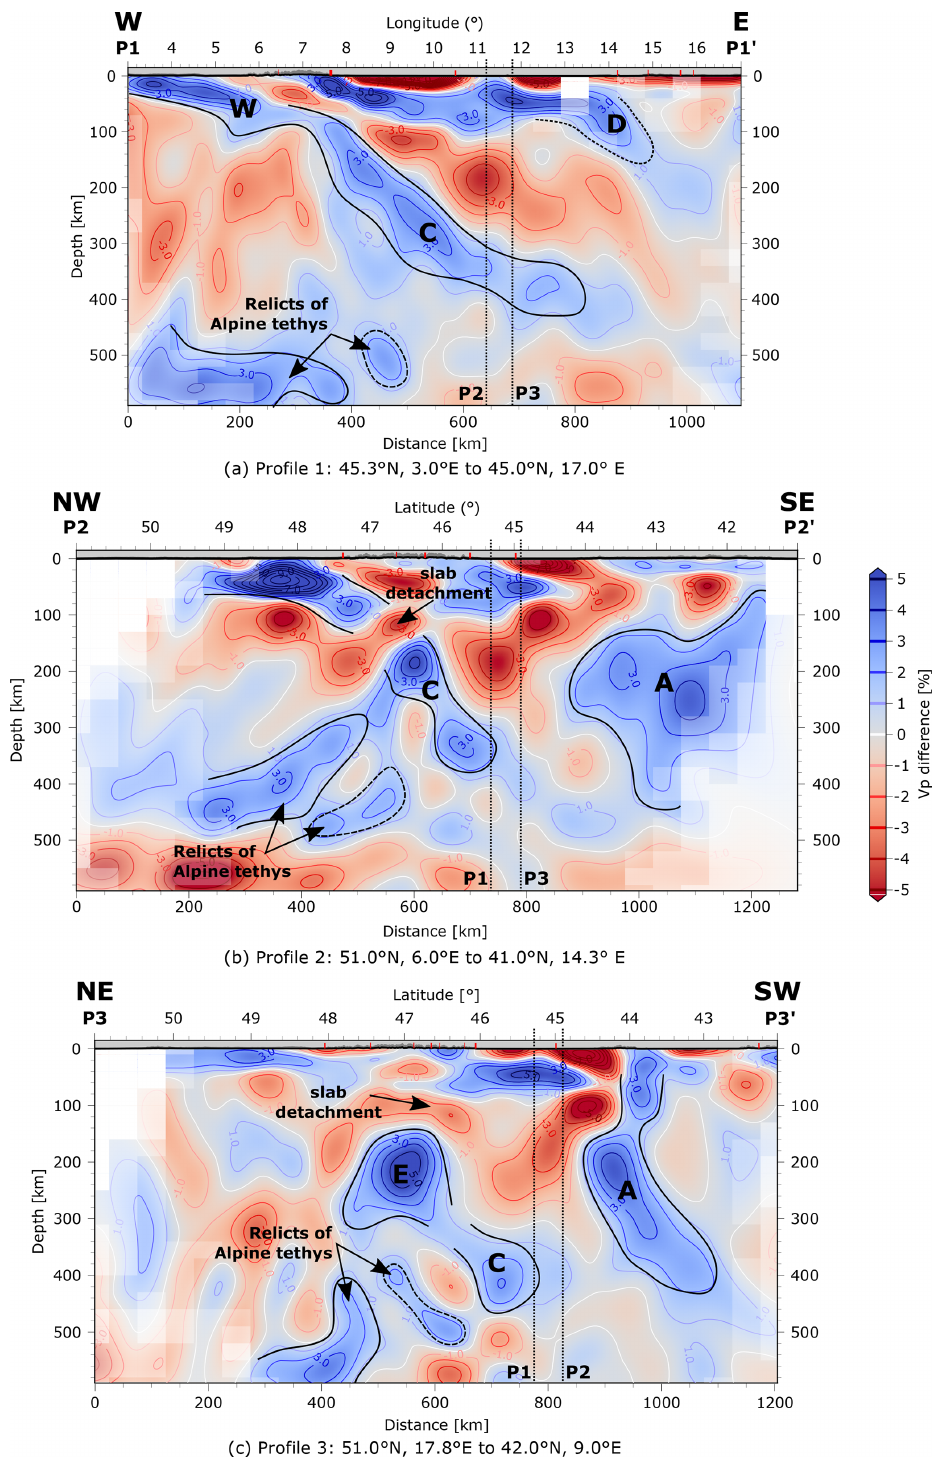
Figure 14. Three vertical profiles cutting through the four major anomalies in the Alps and Apennines as indicated in Fig. 13d: (a) the western Alpine slab, (b) the central Alpine slab and (c) the eastern Alpine slab in the east, as well as the Apenninic slab in the west. Intersections between the different profiles are marked by vertical dashed lines. Distance in kilometres measured at the